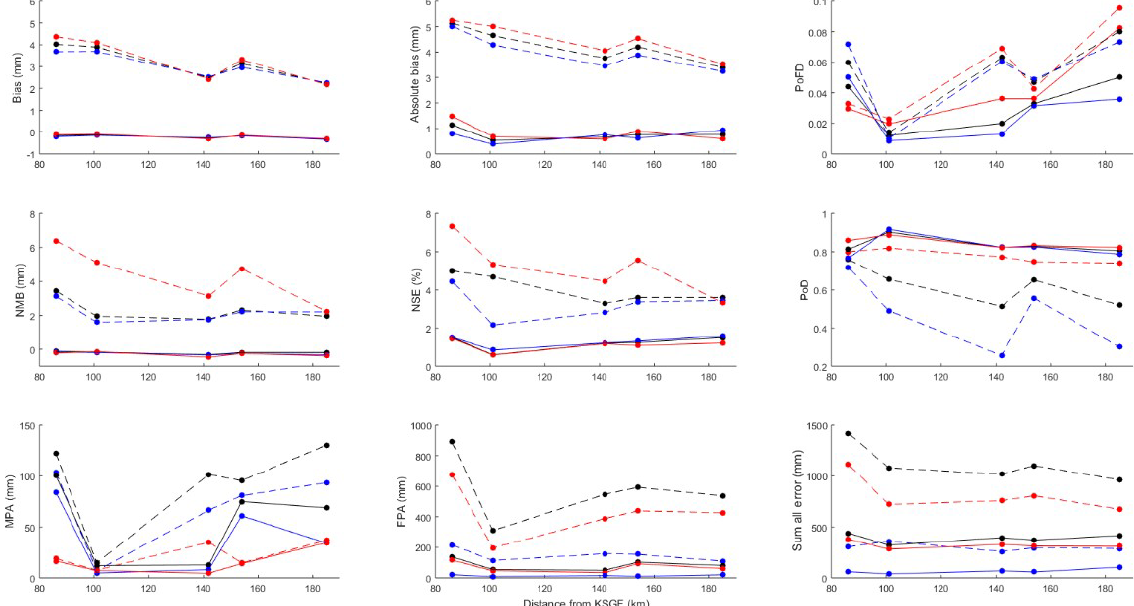
Figure 7. Values of analyses from the Springfield radar. Dashed lines and points represent the analyses of the worst-performing algorithm ( R (ZDR,KDP)), while the solid lines and points represent the analyses of the best-performing algorithm ( R ( Z ,ZDR)). Red, blue, and black colors represent analyses conducted during the warm season, cool season, and overall,